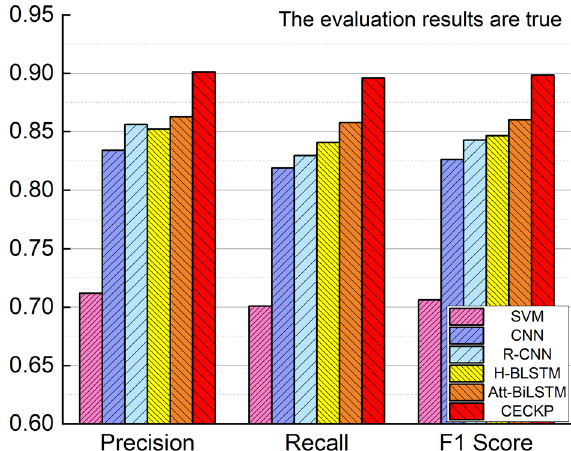
Figure 3. Performance comparison of models on the CECKP-dataset when evaluation results are true.